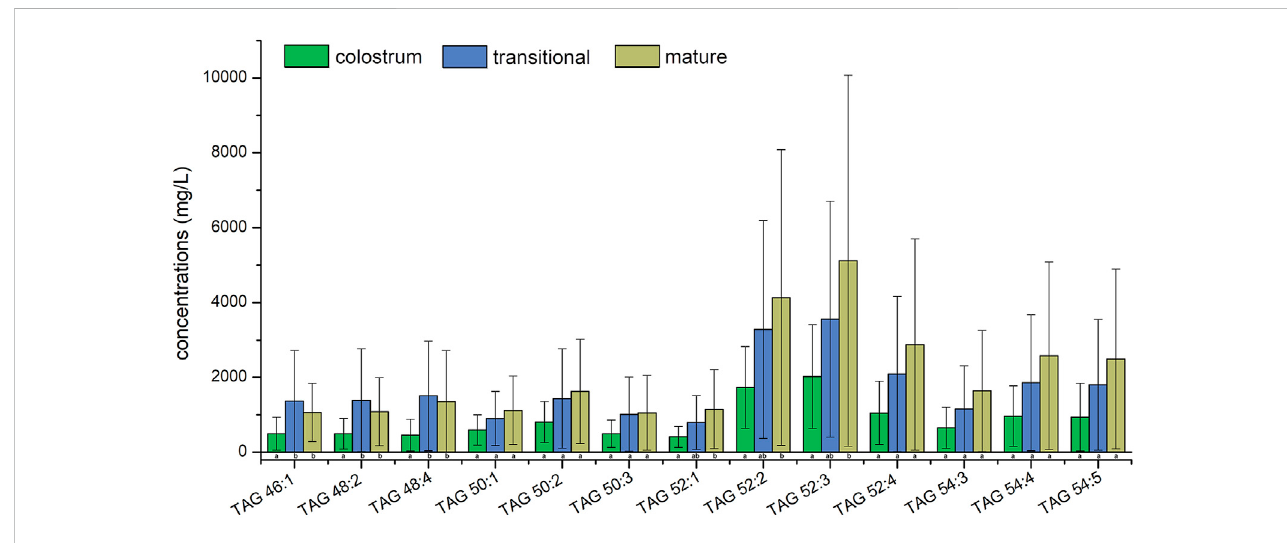
FIGURE 4 Average concentrations of top ten human milk glycerides at different lactation stages.